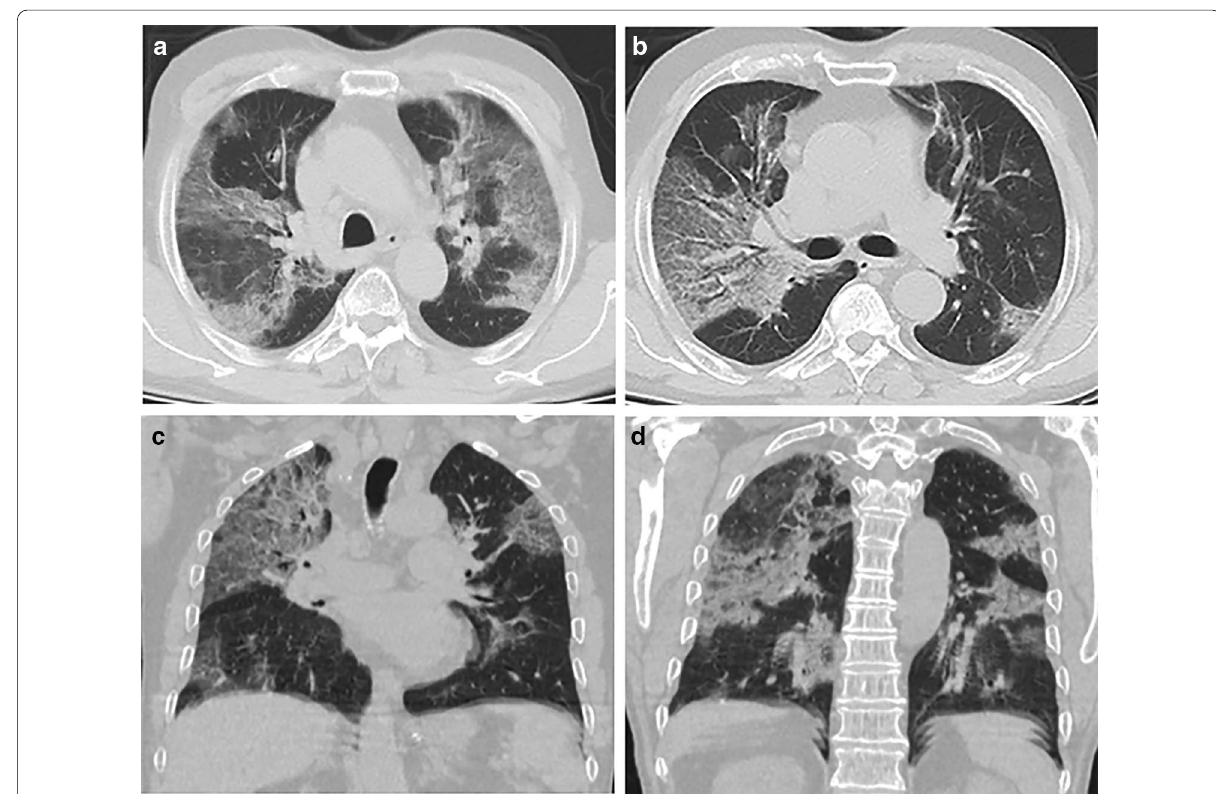
Fig. 3 A 67‑year‑old man with positive RT‑PCR findings for COVID‑19. a–d Noncontrast axial CT images of the chest show bilateral, multifocal peripheral ground‑glass opacities with superimposed interlobular septal thickening and intralobular lines are visible, giving the appearance of “crazy‑paving”. This is in keeping with his CO‑RADS 5 and typical RSNA